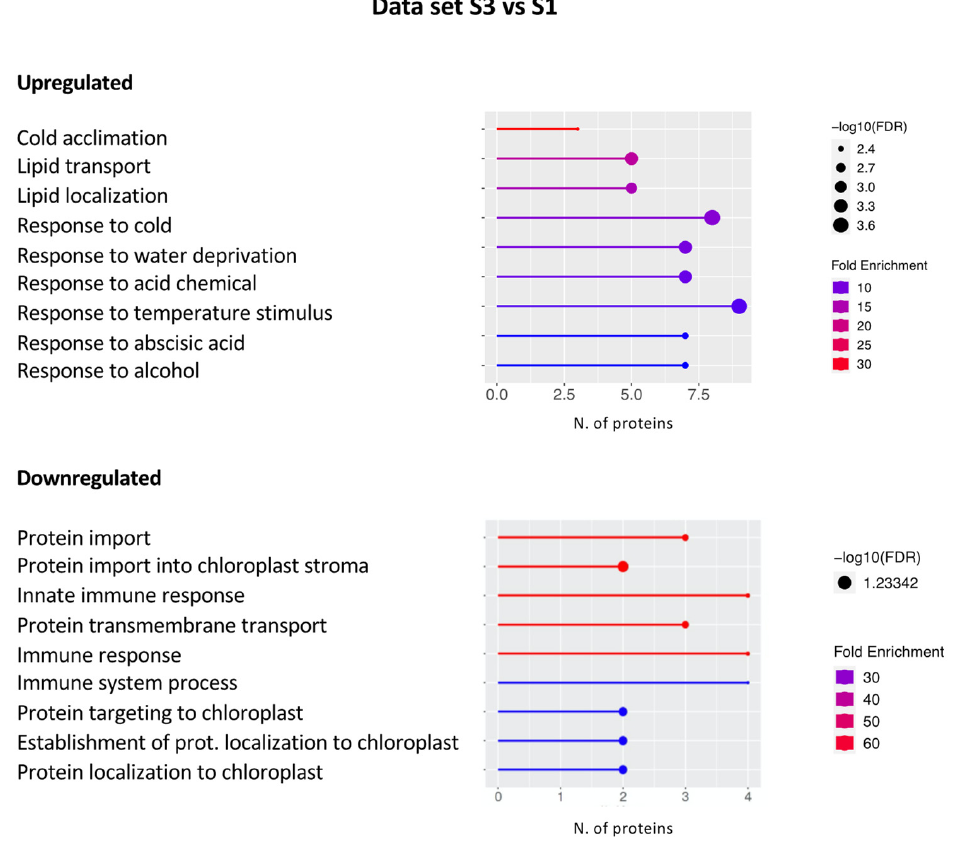
Figure 4. Graphical representation of the GO terms enriched in the S3 vs. S1 data set. The x -axis refers to the number of DEPs upregulated or downregulated that significantly enrich a specific GO term. Lines are colored by a red–blue gradient based on fold enrichment, whereas the size of the circle at the end of the lines is related to the statistical significance ( − log10 FDR).